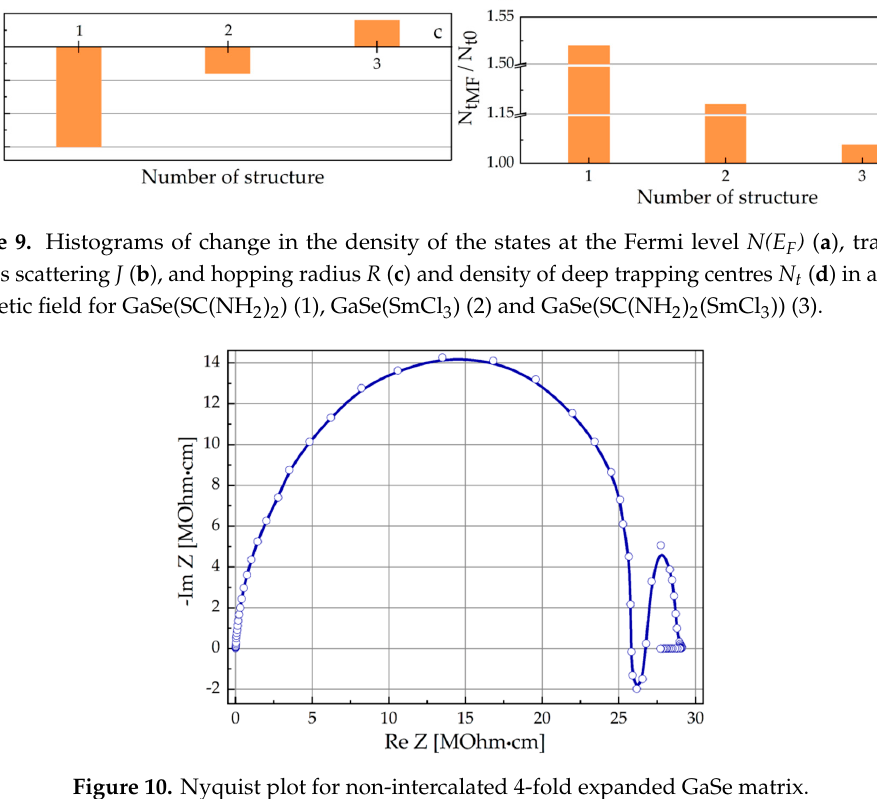
Figure 10. Nyquist plot for non-intercalated 4-fold expanded GaSe matrix. Intercalation of the subhost GaSe lattice by the guest CS(NH 2 ) 2 , SmCl 3 or CS(NH 2 ) 2 (SmCl 3 ) components changes the character of the complex impedance substantially (Figure 11). In the case of GaSe(SmCl 3 ), the strong inductive response was observed in the low-frequency region. Such inductive response, however, disappeared in an applied external magnetic field. This phenomenon, known as negative capacitance [34,35], was studied intensively in a number of works [17,25,36], basically due to the potential related nanoelectronic applications—particularly, with the development of gyrator-free nanodelay lines. The equivalent electric circuit for the relevant low-frequency region of the Nyquist plot is presented in Figure 12. Using the complex amplitude method, such a circuit can be represented by analytical expression 2221 1